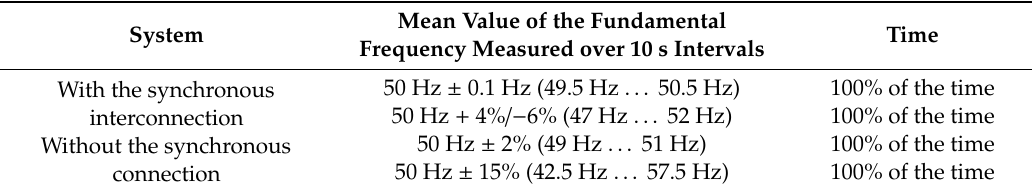
Table 3. Frequency of power supply in the Slovak Republic [15].